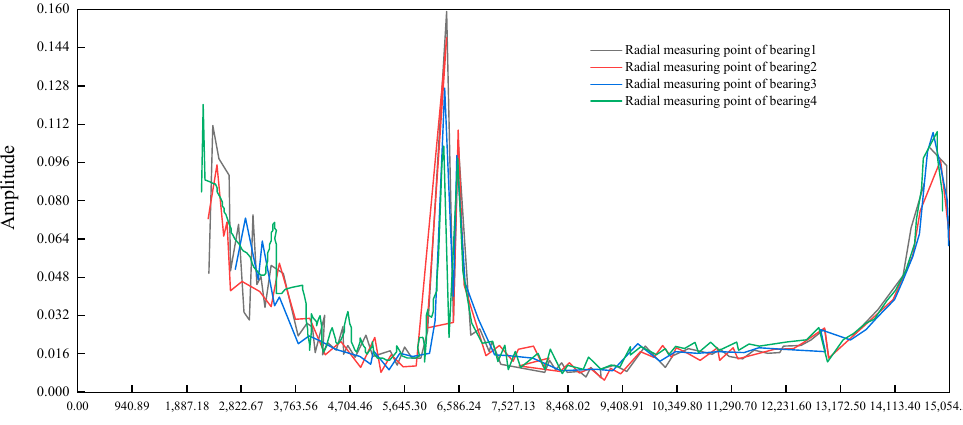
Radial measuring point of bearing1 Radial measuring point of bearing2 Radial measuring point of bearing3 Radial measuring point of bearing4